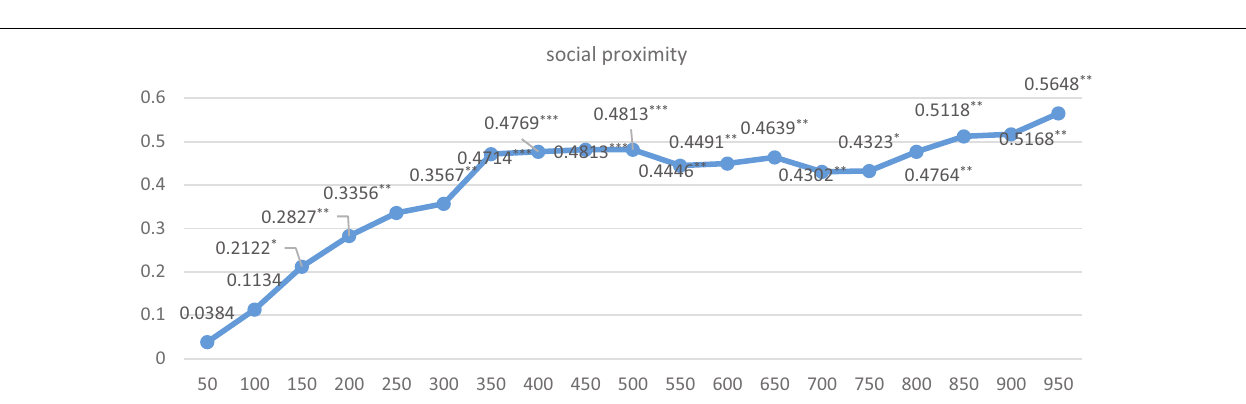
FIGURE 2 | The regression results under geographical proximity with different kilometers. ***, **, and * indicate that the significance level is at the 1%, 5%, and 10%, respectively.